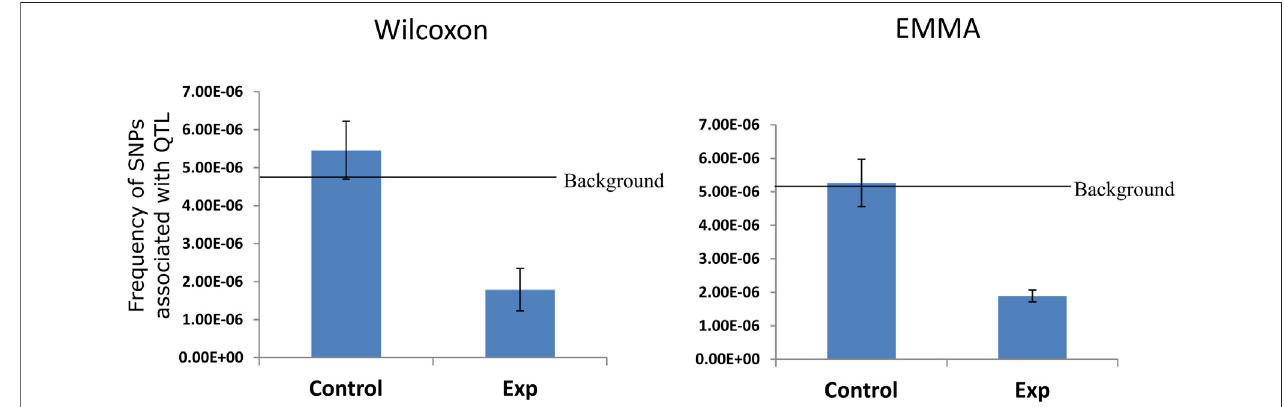
FIGURE 5 | Distribution of SNP associated with QTL in interacting regions. Mapping of publicly available SNP (Atwell et al., 2010) associated with quantitative trait on interacting and non-interacting regions (control), showing more than two times depletion of GWAS hit in the chromatin interacting region over the non-interacting regions. The selected control region is not biased since genome-wide GWAS SNP frequency (background) is similar in the background and control